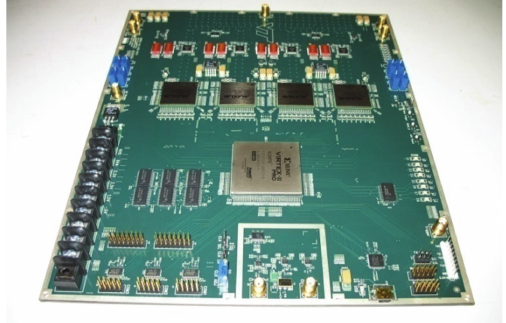
Figure 1: The transceiver